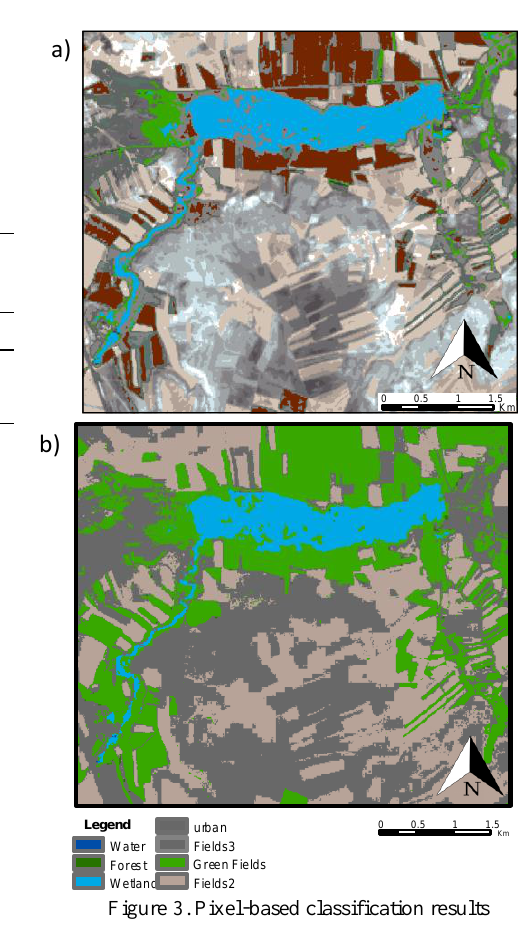
Figure 3. Pixel-based classification